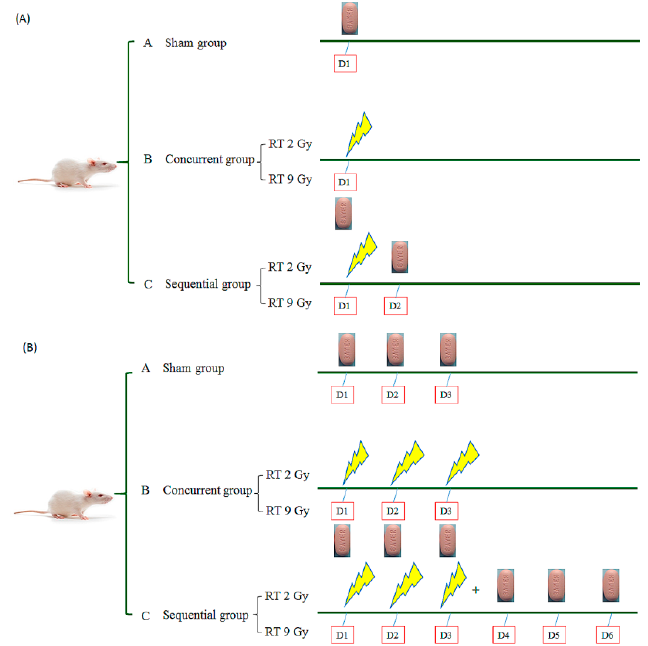
Figure 1. Oral regorafenib 16 (mg/kg/day) delivery with irradiation (i.e., radiotherapy (RT)), under different time schedules and RT doses. ( A ) The one fraction study groups; ( B ) The continue treated groups. The rats were randomly divided into ten groups with six rats in each